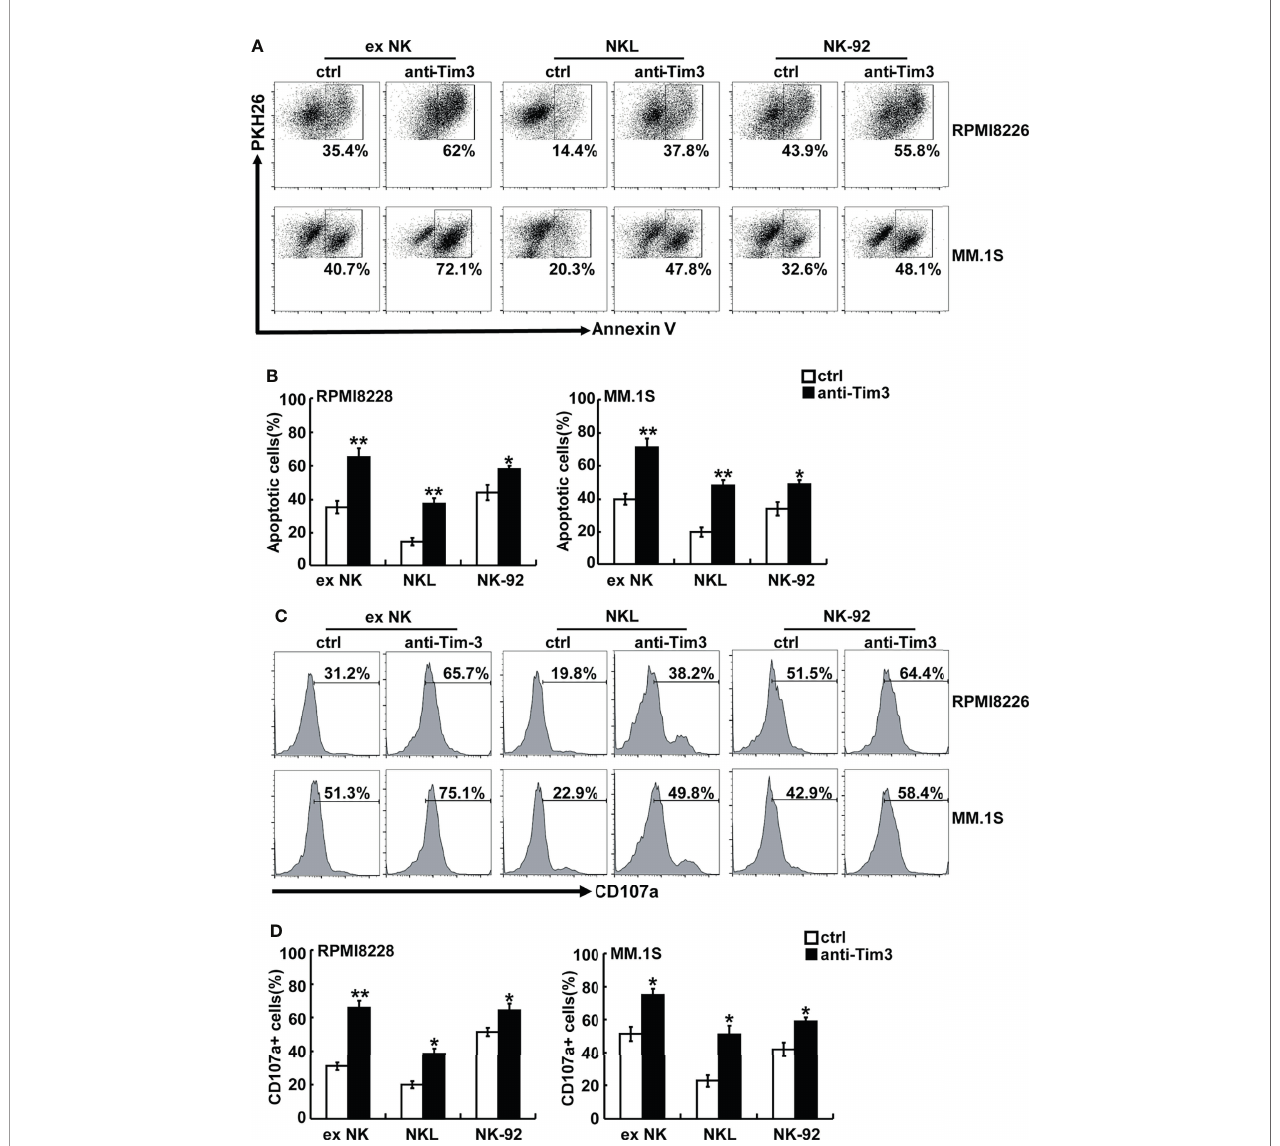
FIGURE 3 | Tim-3 blockade enhanced NK cell-mediated natural cytotoxicity against human MM cell lines. exNK, NKL, NK-92 cells were used as effector (E) cells and human MM cell lines were used as target (T) cells. The E:T ratios of exNK, NKL, NK-92 cells were 1:1, 5:1, 1:1, respectively. (A, B) Cytotoxicity activity of NK cells was tested by PKH26/Annexin-V stain. The cytotoxicity of NK cells was determined by the percentage of apoptotic MM cells at the indicated E:T ratios after pre-incubation with 10 m g/ml anti-Tim-3 antibodies. (C, D) The degranulation level of NK cells was detected by CD107 degranulation assay. The dot plots illustrating CD107a surface expression on the NK cells after stimulation by the target cell lines, respectively. One representative of at least three independent experiments. Data shown were mean ± SD of at least three independent experiments. * P < 0.05, ** P < 0.01 versus control NK